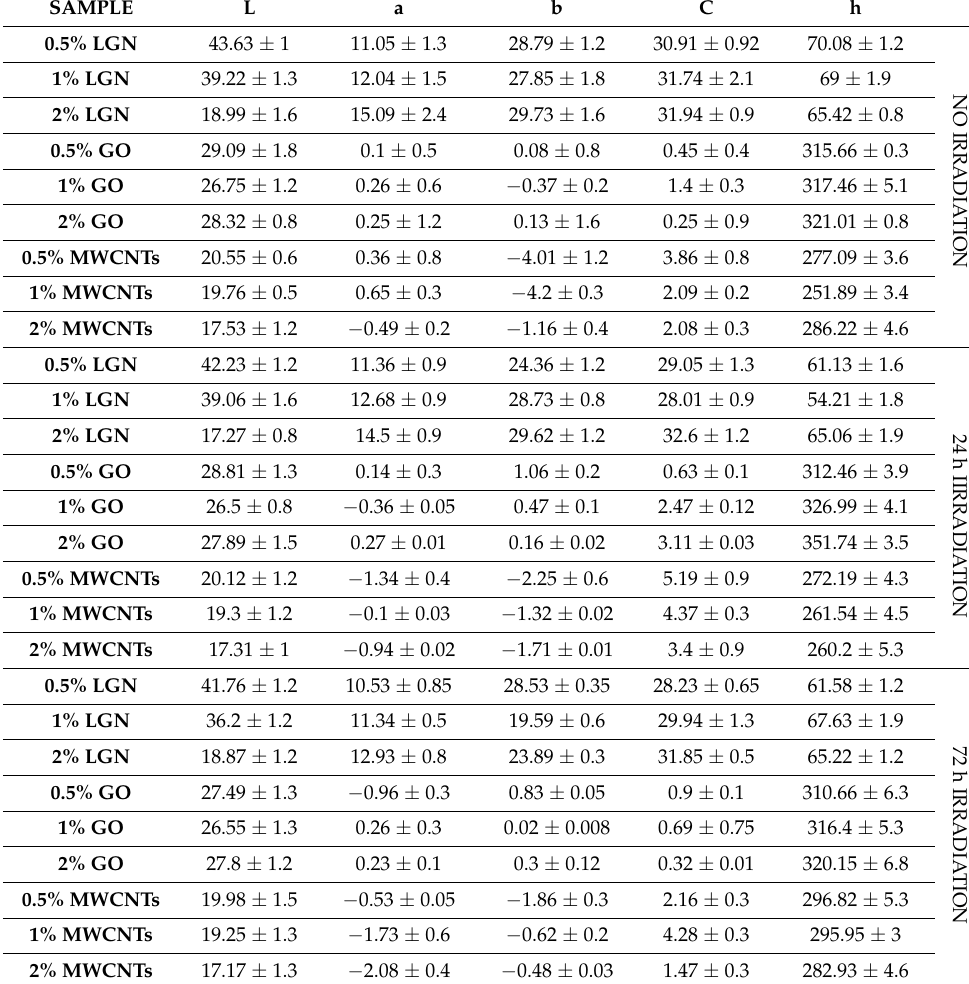
Table 3. Color components of LGN, MWCNTs and GO containing emulsions with no UV exposure and after 24 and 72 h of UV